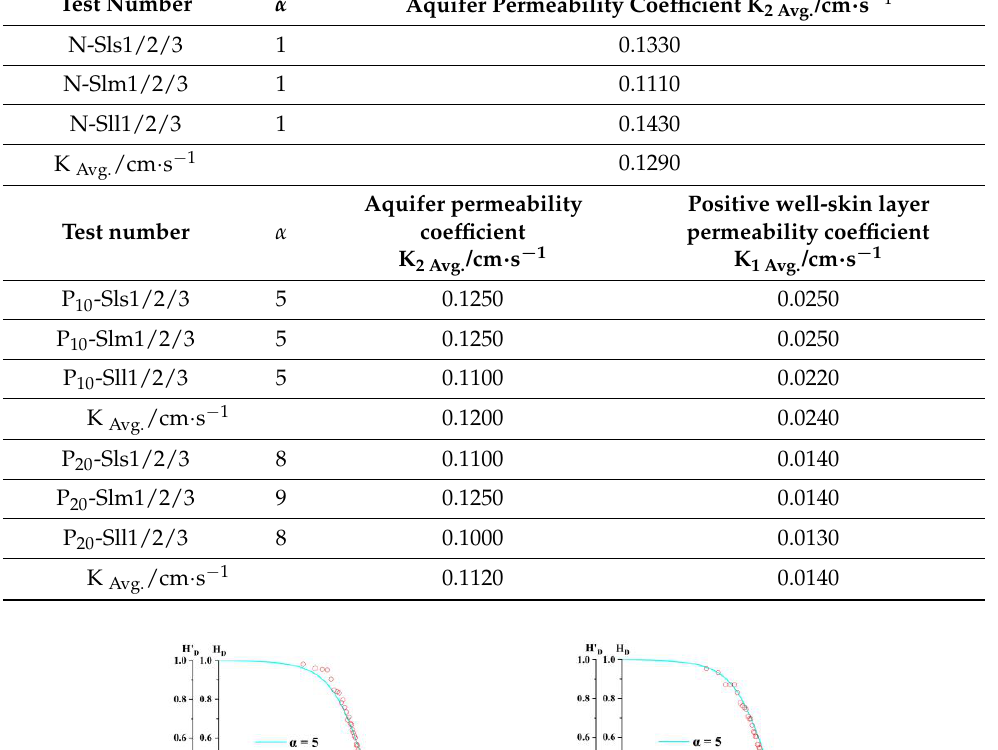
Table 5. Calculation results of permeability coefficient determined by slug test based on HWS model under different well-skin effects.